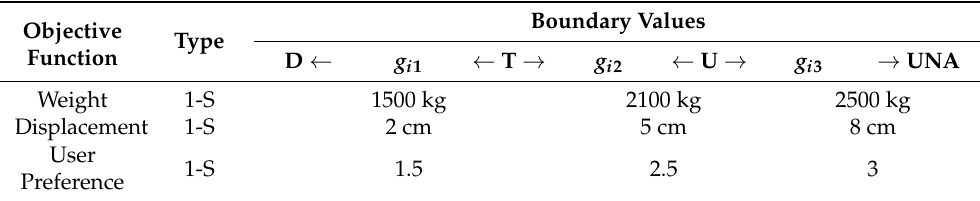
Table 8. Boundary values of objective